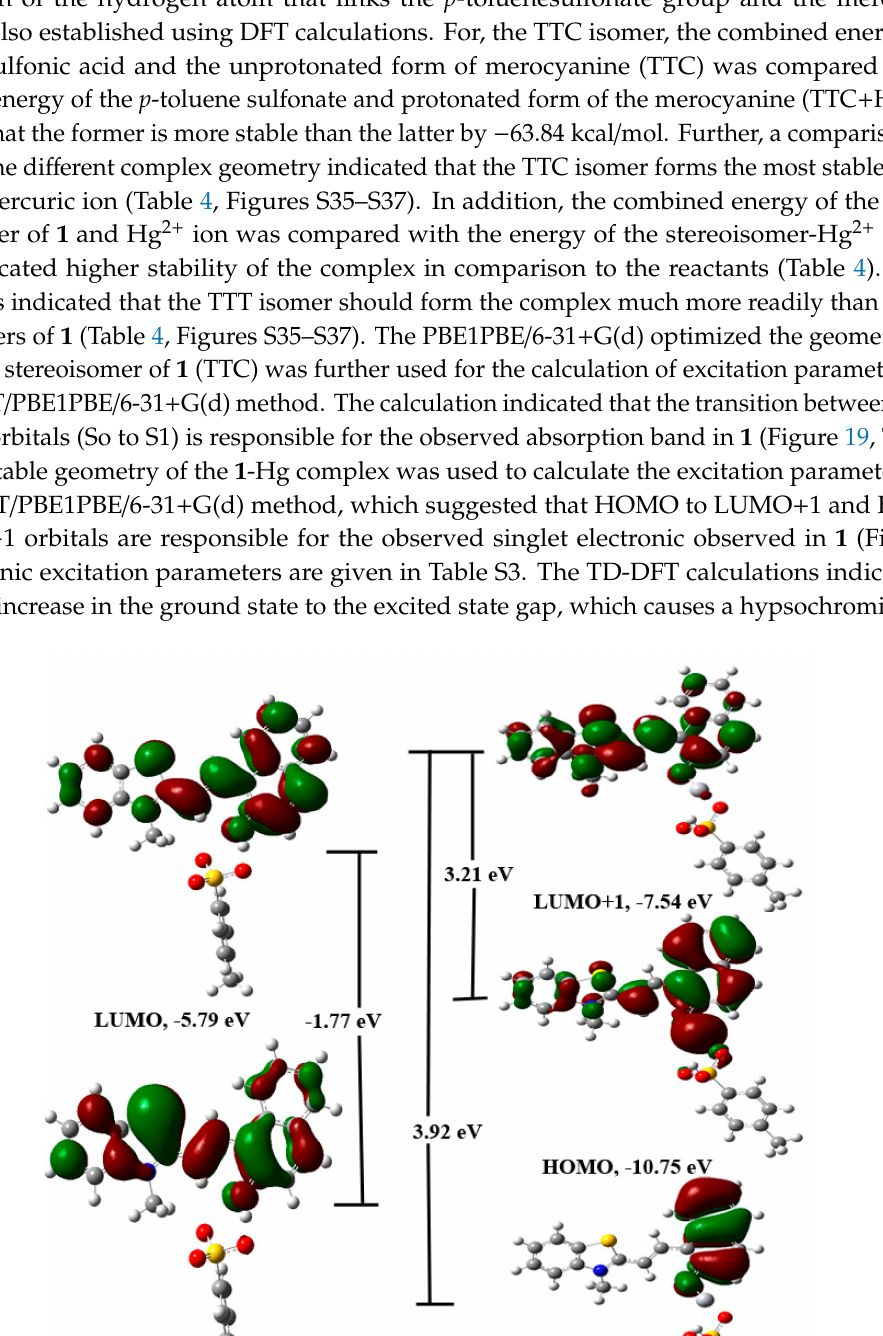
complex showing main orbitals involved in the